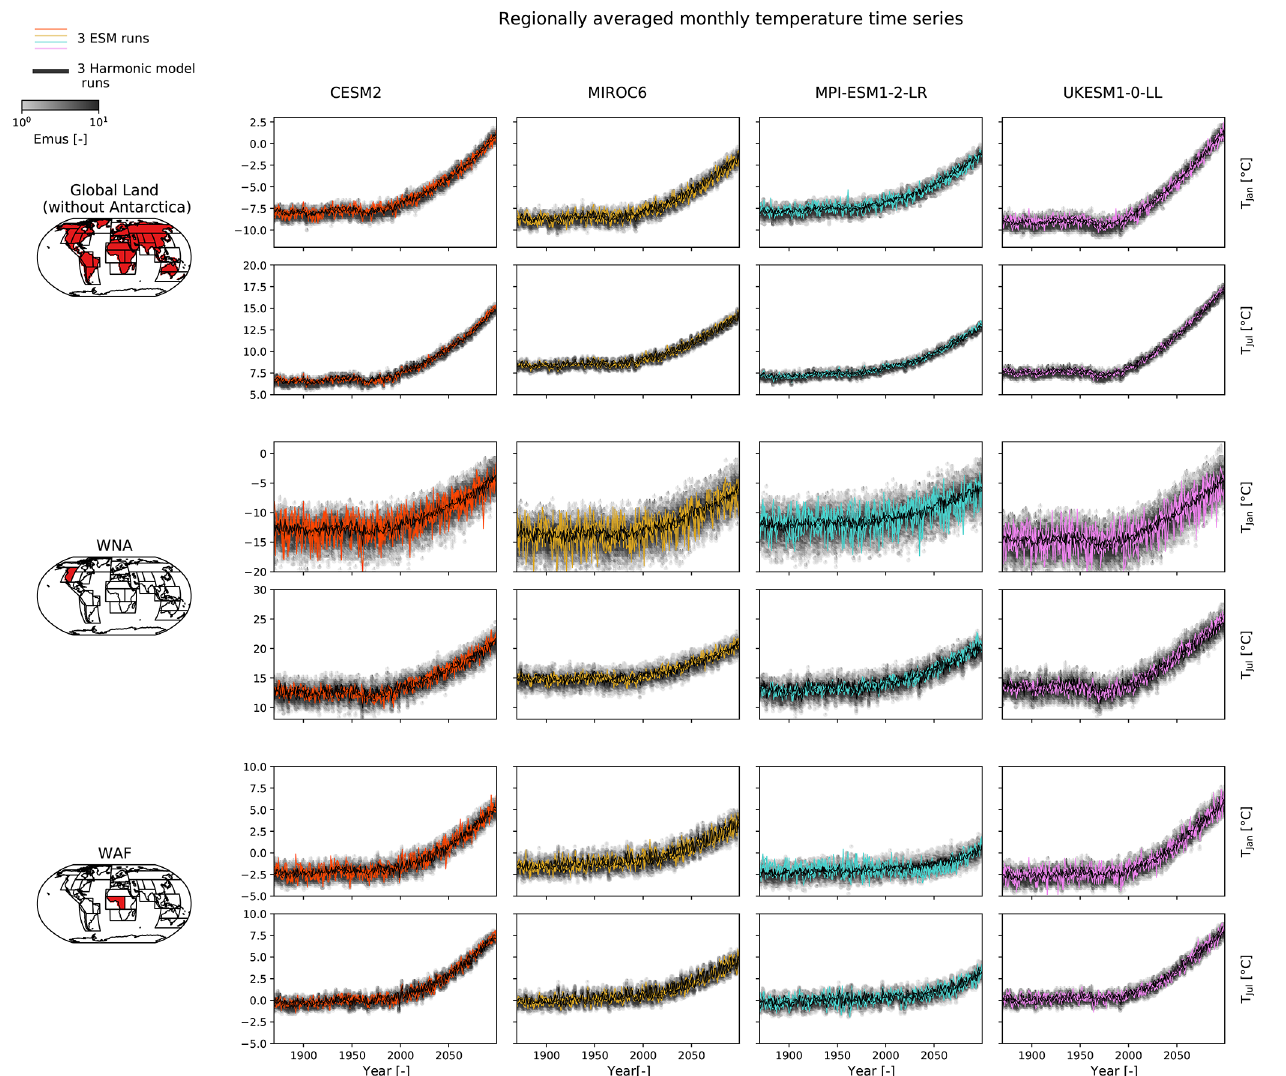
Figure 3. Regionally averaged temperature time series (rows) of January and July for four example ESMs (columns). Three ESM ensemble runs (coloured), their respective harmonic-model results (black), and 50 full emulations (emus) for each of the three patterns (grey colour scale) are plotted. Temperature values are given as anomalies with respect to the annual climatological mean over the reference period of 1870–1899. The regions are, from top to bottom, global land without Antarctica, western North America (WNA), and West Africa